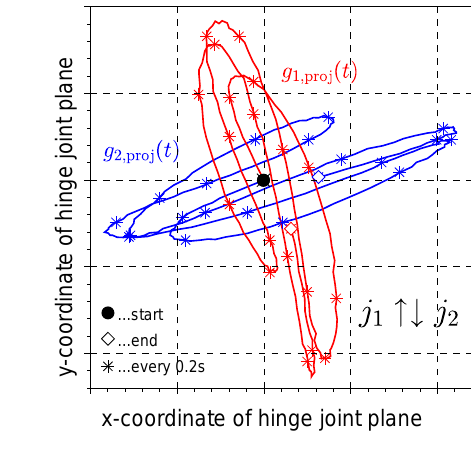
Figure 4. Projection of the measured angular rates of both sensors into the joint plane (defined by the coordinates in Equation (13)) for a motion with little flexion/extension. In both plots, the projections have the same length at each moment in time, cf. Equation (3). However, when the joint axis signs match, the two curves are congruent up to some rotation around the origin, while in the case of opposite signs, they are mirror images of each